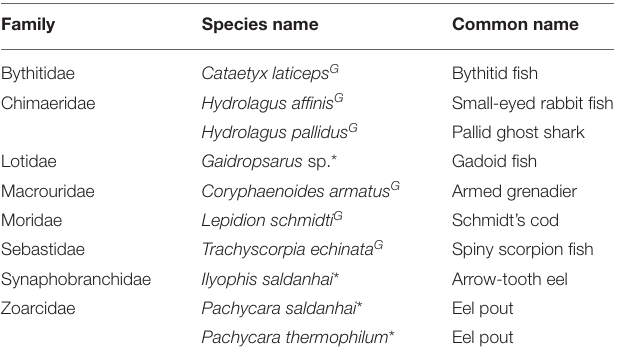
TABLE 3 | Fish species recorded from hydrothermal vents along the Mid-Atlantic